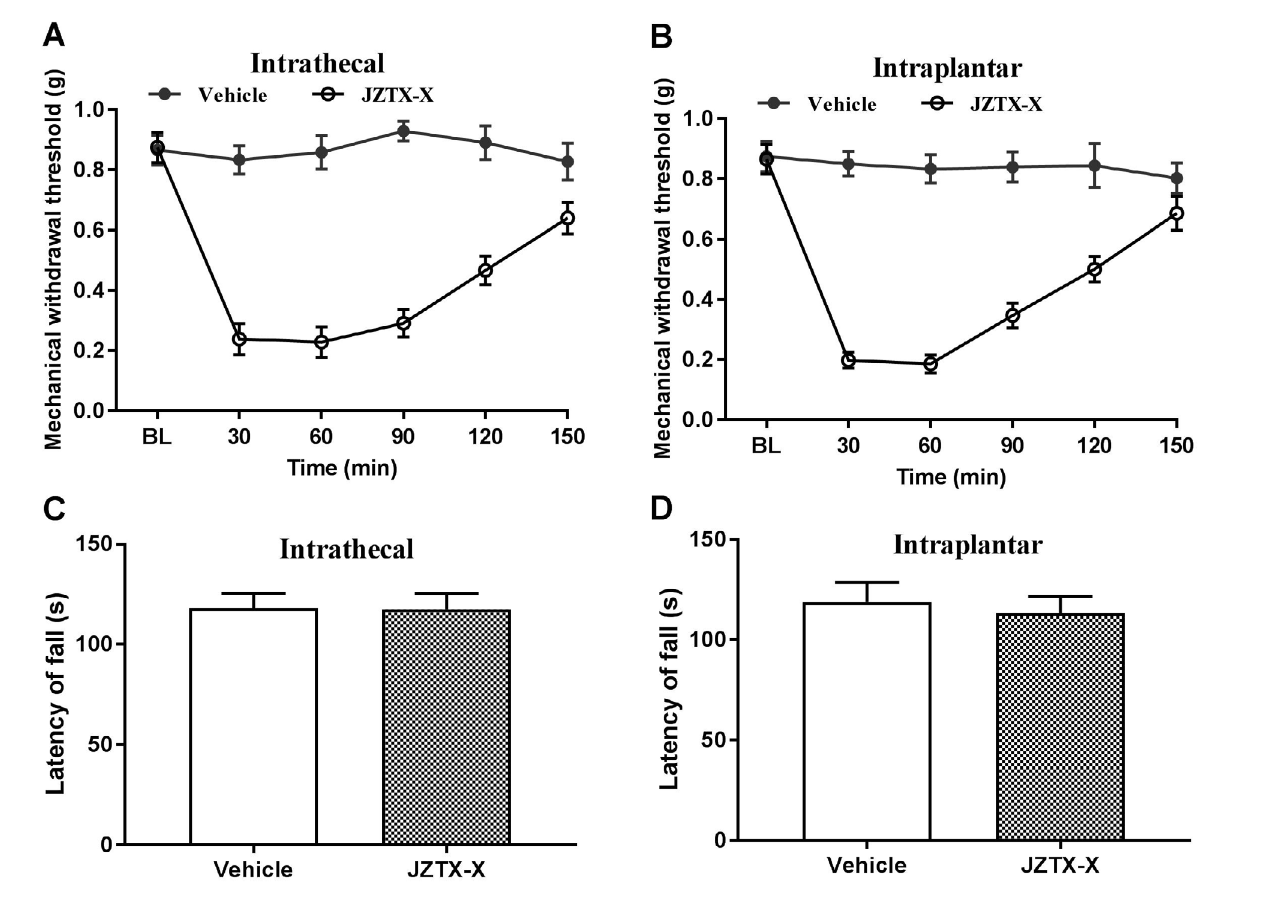
Figure 8. Effects of JZTX-X on the mechanical hypersensitivity and motor activity. (A-B) Effects of JZTX-X on mechanical hypersensitivity detected by von- Frey tests. Drugs were given to mice through intrathecal (A) or intraplantar (B) infusion. (C-D) Effects of JZTX-X on the motor activity detected by rotarod tests. Mice were given intrathecal (C) or intraplantar (D) infusion. Mice were put onto the rod at 30 min following JZTX-X treatment. Data were expressed as mean ± S.E. n = 8 rats for each